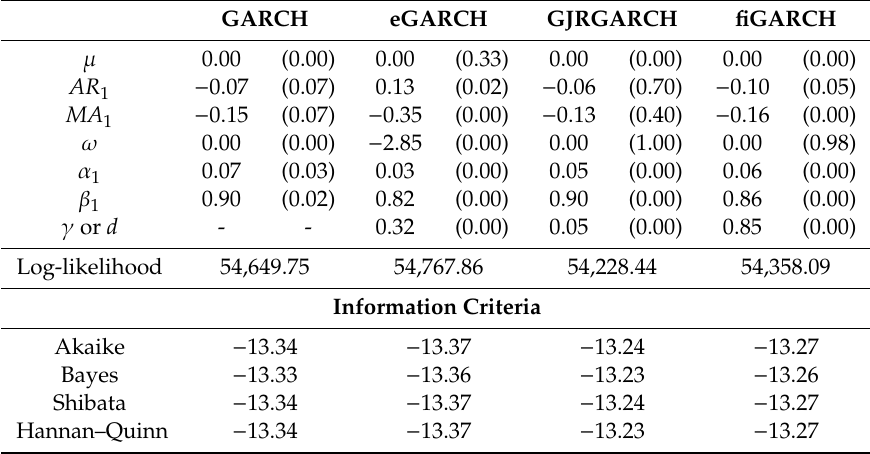
Table 4. GARCH (1,1) models estimates.